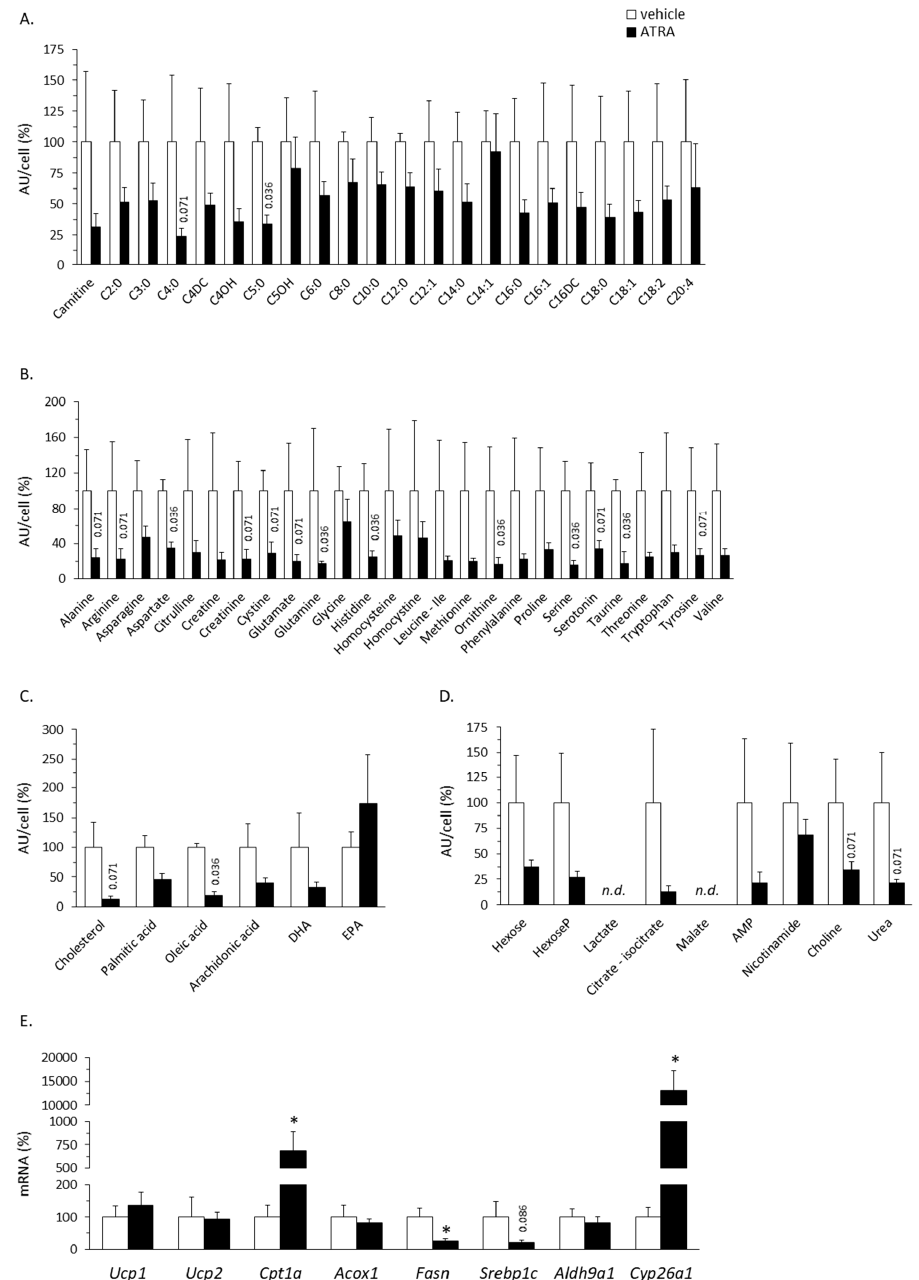
Figure 6. Relative plasma levels of carnitine and acylcarnitines ( A ), amino acids ( B ), the indicated fatty acids ( C ), the indicated metabolites / cofactors of intermediary metabolism ( D ), and the indicated mRNAs ( E ) in PBMC of mice treated with all-trans retinoic acid (ATRA; 50 mg / kg body weight, subcutaneous injection) or the vehicle (olive oil) during 4 days. Data are the means ± SEM of 3–5 mice per group and are expressed relative to the mean value of the control (vehicle-treated) group, which was set to 100. In A – D , metabolite peak area (as arbitrary units, AU) was normalized per cell, and observed p values in Mann–Whitney U test are indicated when p < 0.1 (significances disappeared after Benjamini–Hochberg correction). In E , mRNA levels were normalized to the mRNA levels of the reference gene Actb, * indicates a significant di ff erence between the ATRA and the control group ( p < 0.05), and p values are indicated when 0.05 < p < 0.1 (Mann–Whitney U